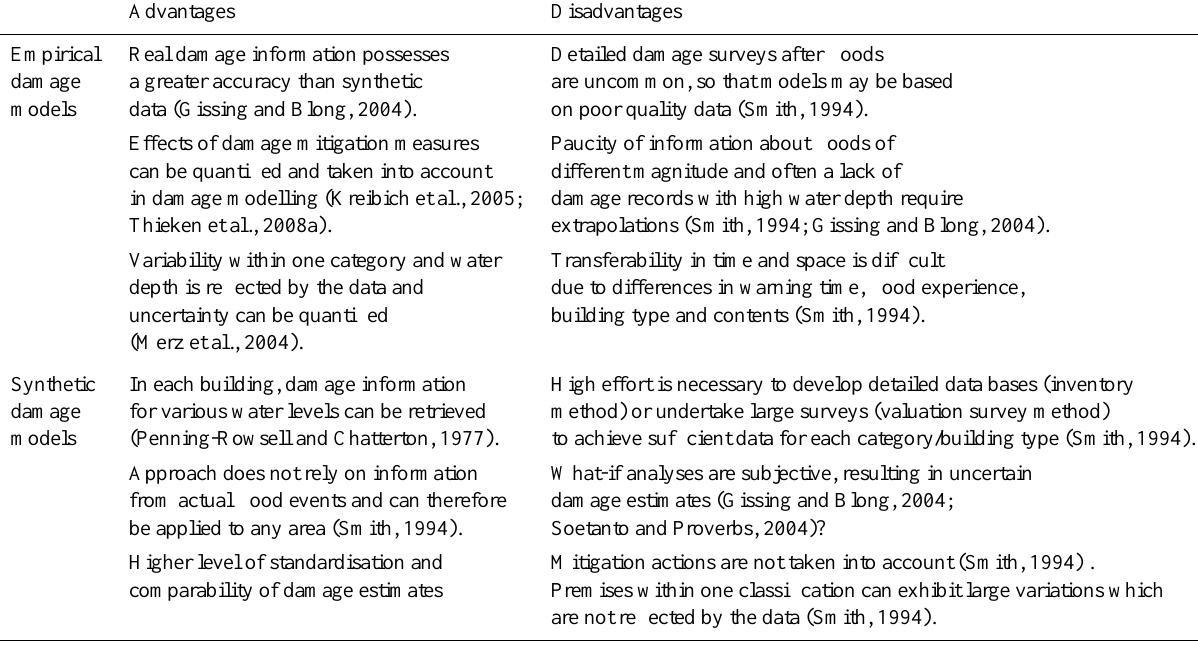
Table 4. Advantages and disadvantages of empirical and synthetic flood damage models.